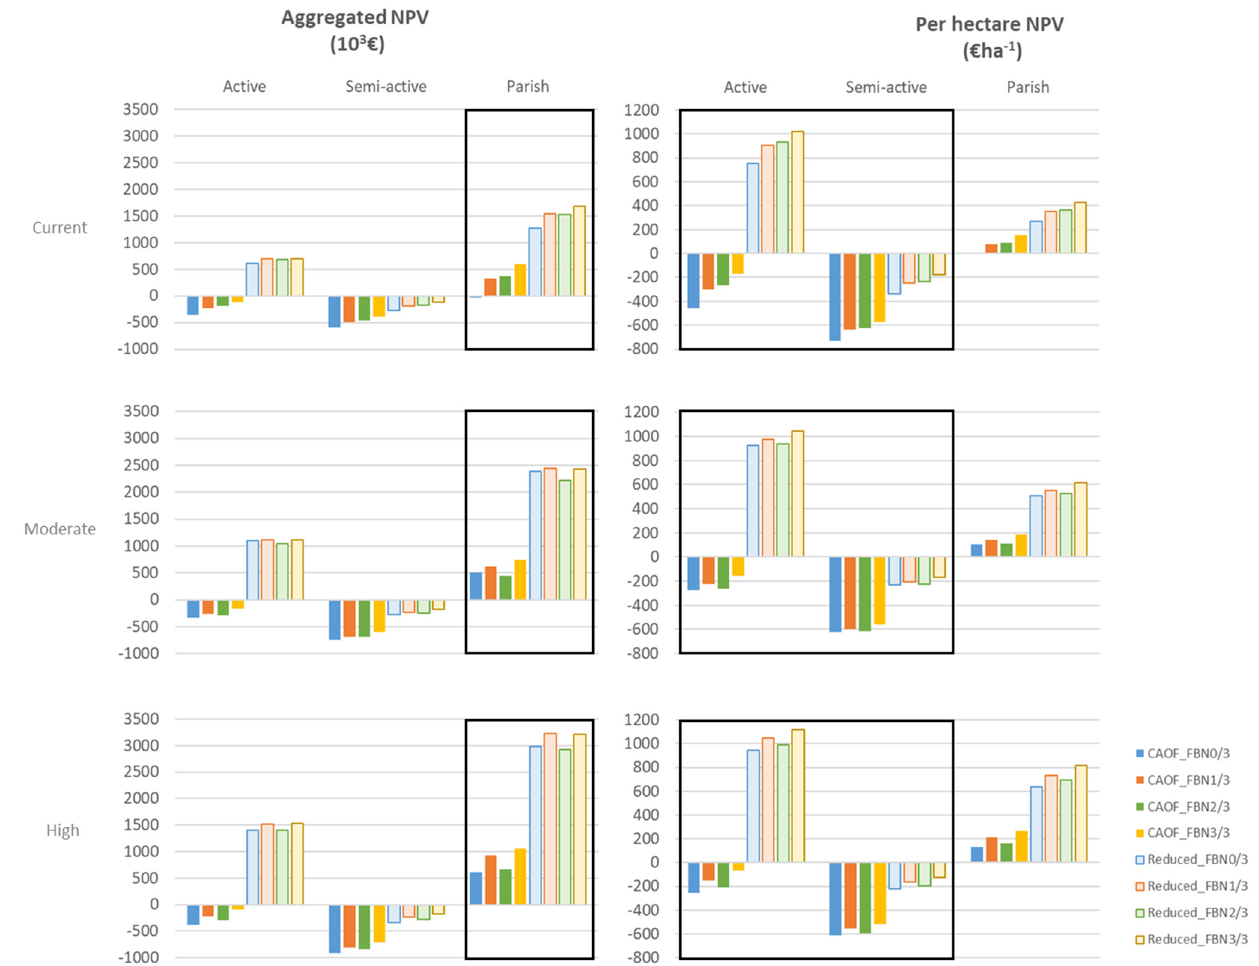
Figure 8. Aggregates and per ha NPV considering CAOF and reduced operations’ prices for all the fire scenarios.